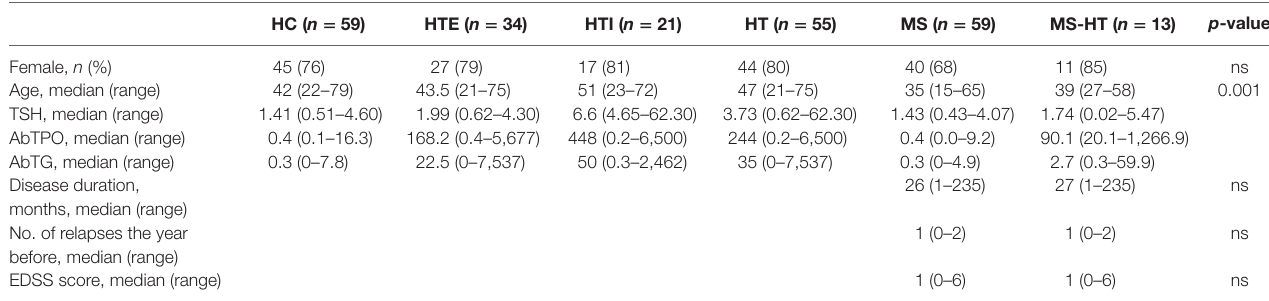
TaBle 1 | Demographical and clinical